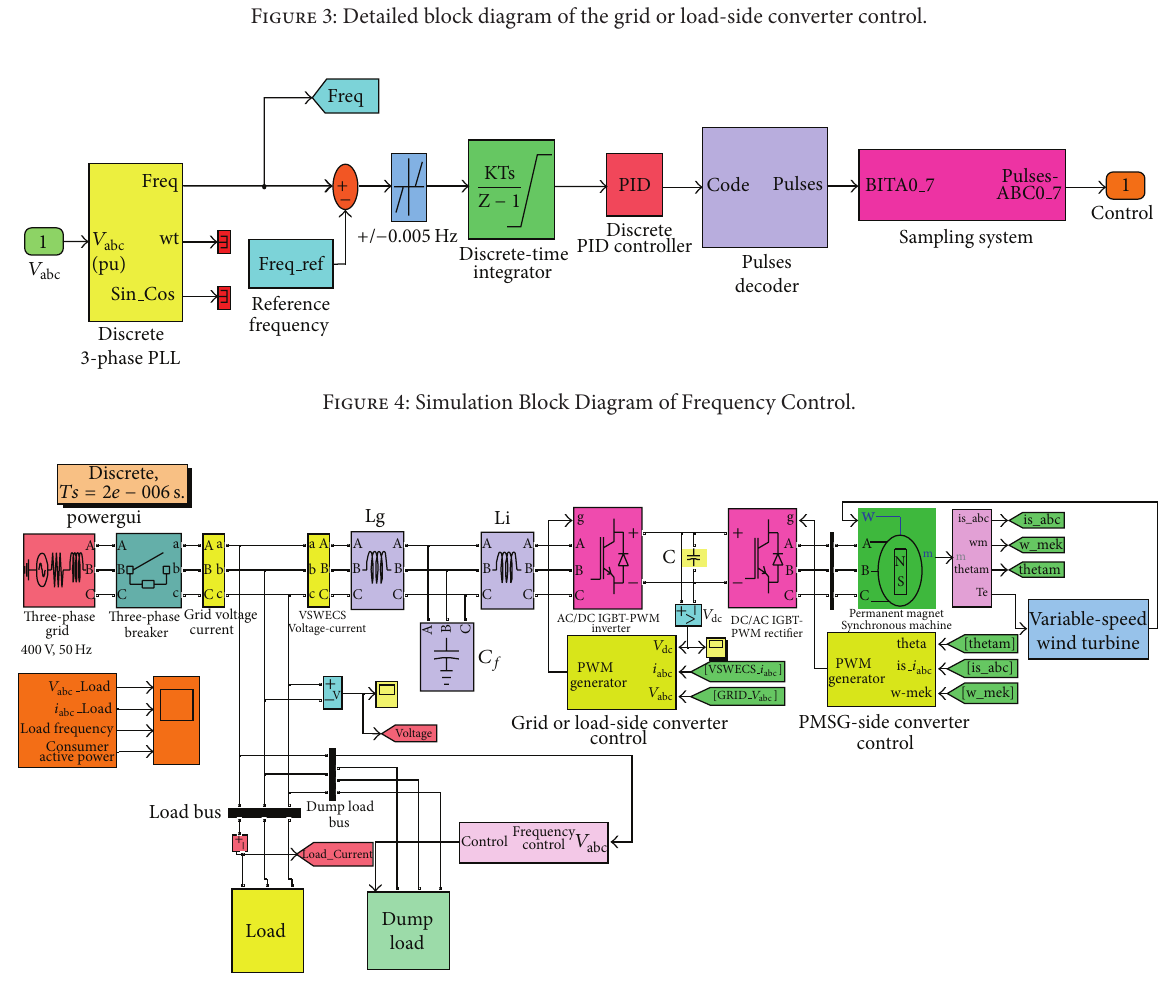
Figure 5: Detailed simulation block diagram of the PMSG-based VSWECS with IGBT-PWM converter connected to grid or